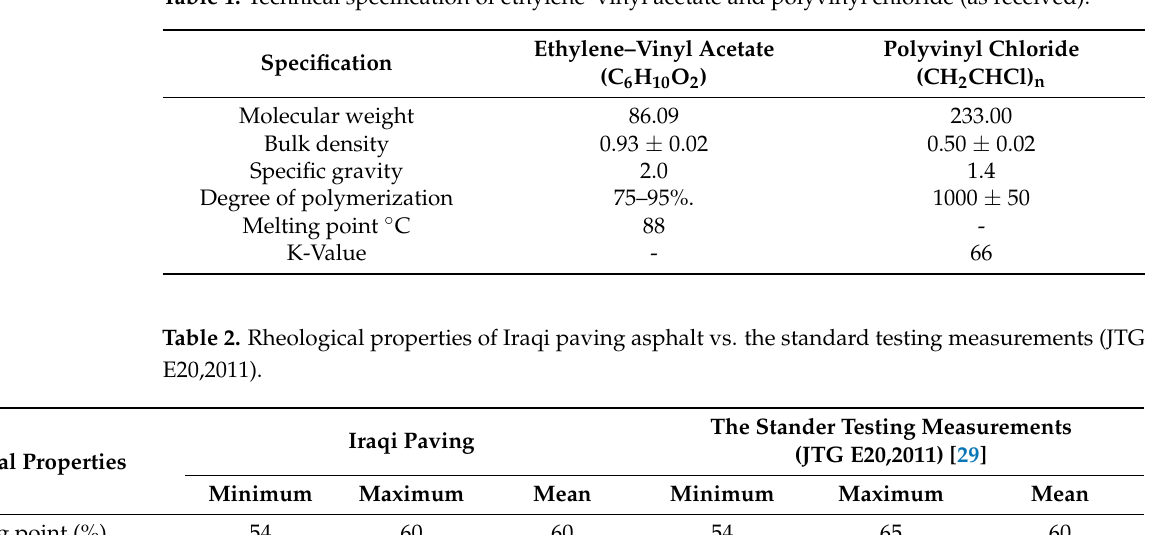
Table 1. Technical specification of ethylene–vinyl acetate and polyvinyl chloride (as received).